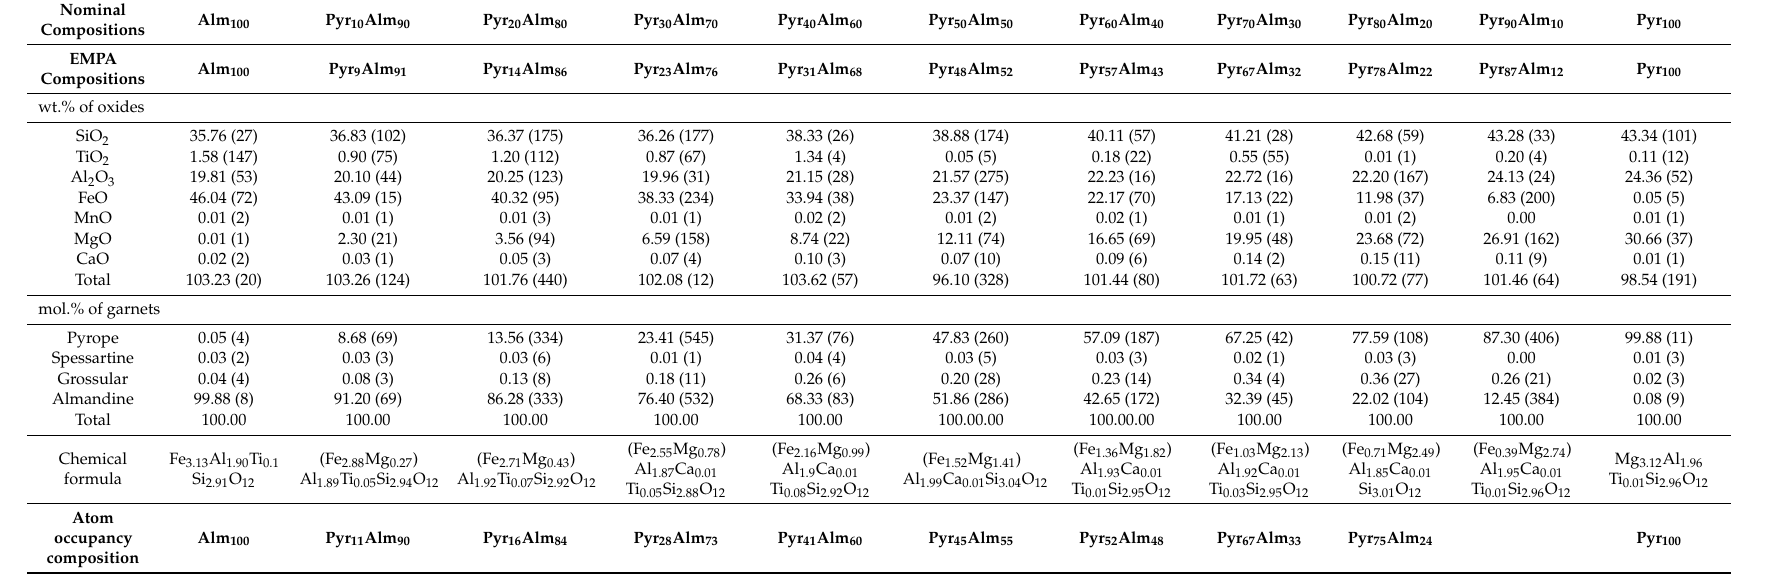
Table 1. Garnet compositions along the pyrope–almandine solid